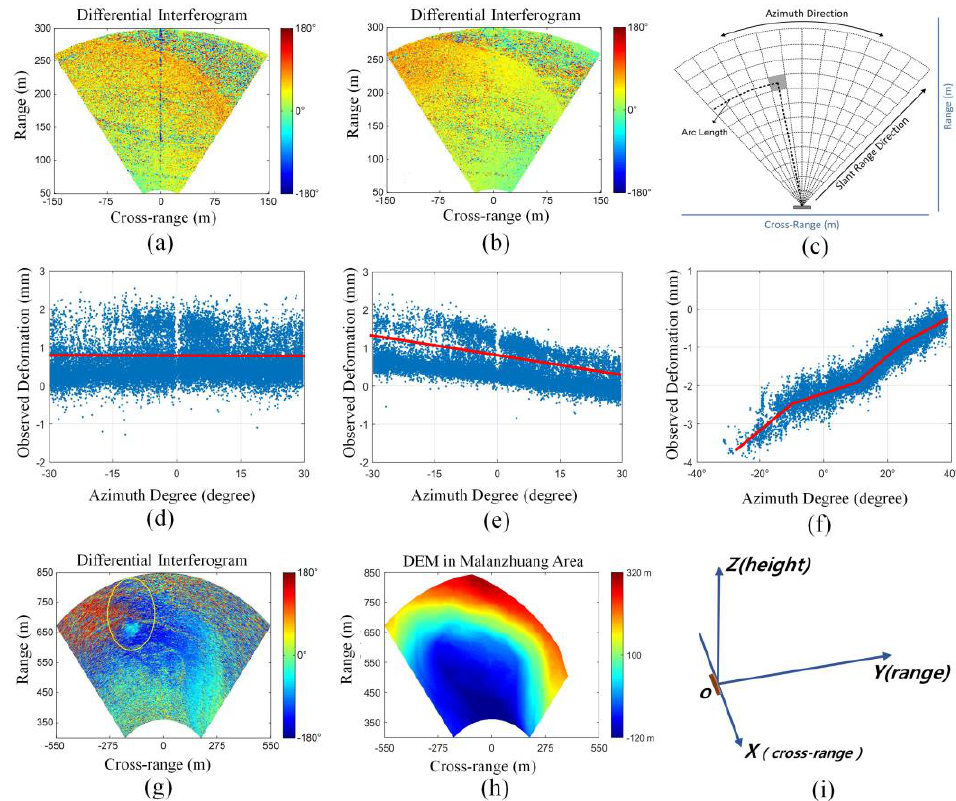
Figure 4. ( a – e ) illustrate the APS in the 2D observation scenario in the Linjiaping area. ( a , d ) are the differential interferogram and the phase of high-quality points in the azimuth direction for a homogenous APS, and ( b , e ) are those for a non-homogenous APS. In ( d ), the phase is a constant along the azimuth direction that indicates the homogenous APS, whereas in ( e ) it changes linearly along the azimuth direction, indicating the non-homogenous APS. The azimuth direction, under the polar coordinate system, is illustrated in ( c ). ( f – i ) illustrate non-homogenous APS in the 3D observation scenario in the Malanzhuang area. ( g ) is differential interferogram, ( f ) is the unwrapped phase of the high-quality points along the azimuth direction for ( g ). ( h ) is the DEM in the radar geometry for the Malanzhuang area. The APS is also non-homogenous in ( g ), as the phase reversal, indicated by the yellow circle, happens in neither the slant range nor the height direction. However, different from the linear trend of the APS in ( e ), the APS in ( f ) shows non-linear change along the azimuth direction due to the steep topography. To transform the non-linear APS correction in the polar coordinate system into a linear problem, the rectangular coordinate system ( i ) is introduced.